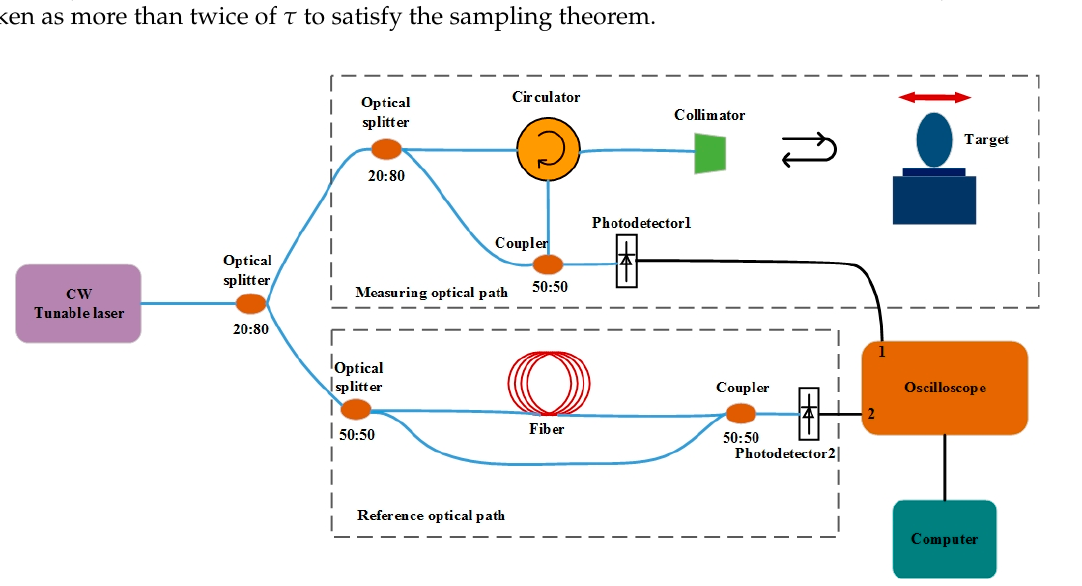
Figure 1. Schematic diagram of the FSI-based absolute ranging system.